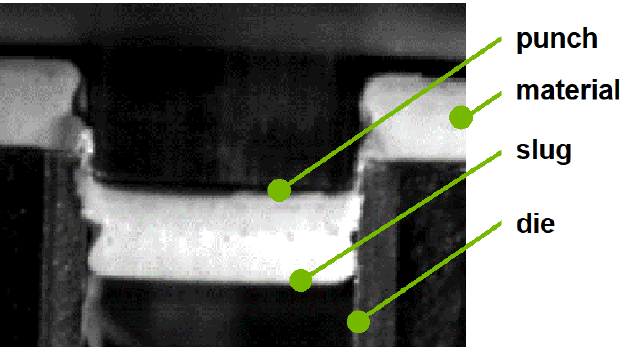
Figure 3. Cross-section view of the separation of the PC/ABS material while punching.